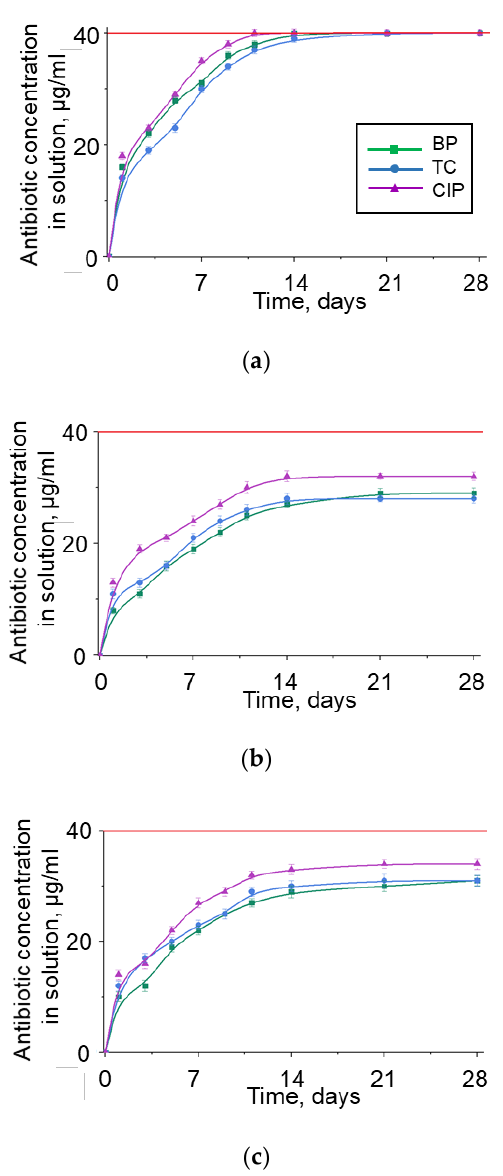
Figure 7. Kinetics of BNNPs purification from antibiotics at an initial antibiotic concentration of 40 μg/mL. Method 1 ( a ); Method 2 ( b ); Method 3 ( c ).